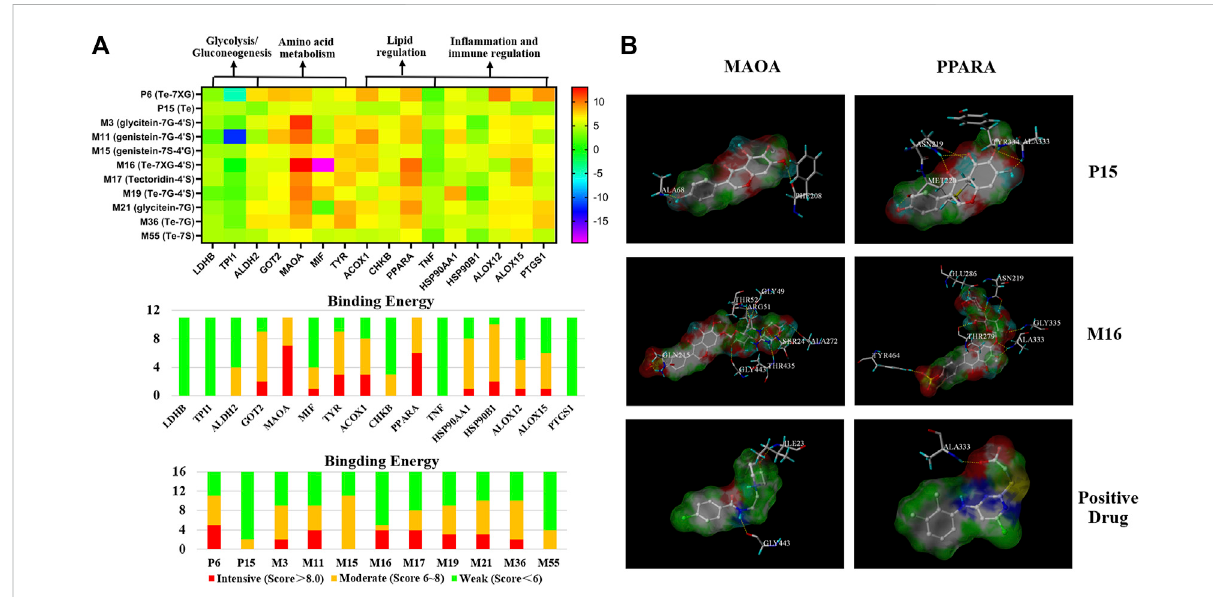
Binding interaction between the active metabolites and potential targets predicted by network analysis. (A) Binding energy between 11 constituents with 16 targets performed by docking. (B) Binding mode of tectorigenin (P15), 6 ″ -O-xylosyltectoridin-4 ′ -sulfate (M16), and positive drug with MAO-A and PPAR- α . (Compounds are presented with the thick stick style; hydrogen bonding interactions are expressed by yellow dotted lines. Amino acid residues which form H-bonds are presented by thin line and labeled with residue sequence.)